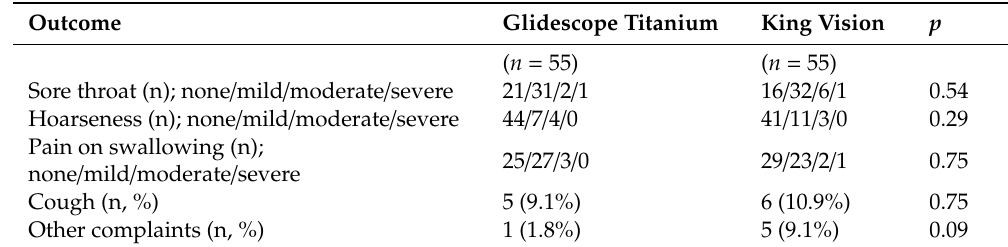
Figure 5. Linear regression model between increasing IDS and BMI in the KVL group. Table 3. Postoperative